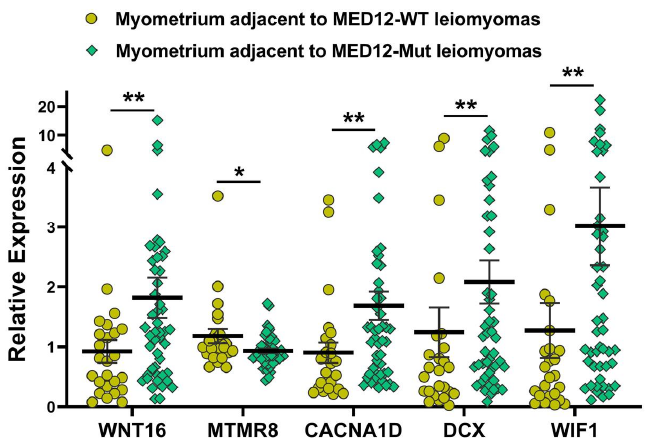
Figure 4. The expression of selected genes from the analysis of the myometrium (n = 73) based on MED12-mutation status of their paired adjacent leiomyomas by qRT-PCR. The results are presented as mean ± SEM with p values (* p < 0.05; ** p < 0.01) as indicated by the corresponding lines.